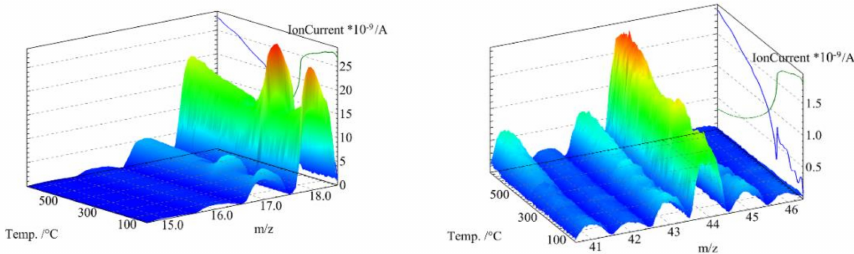
Figure 4. Mass spectra of gases evolved during the thermal treatment of CS-CuPc.